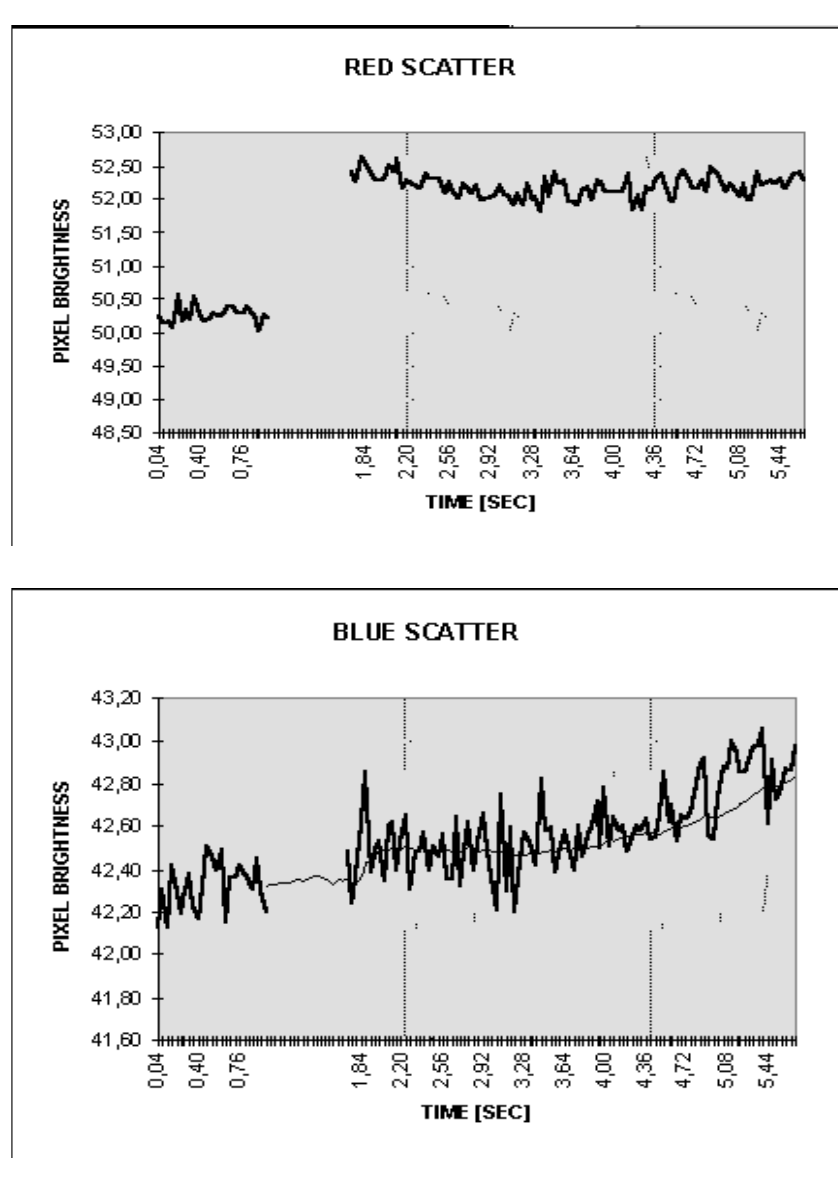
Figs. 2A and B – Mean brightness of a 750 µm 2 area centered at the pixel with the stimulating needle tip and calculated in a 125 frames sequence (25Hz video acquisition frequency). The sequence begins one second (25 frames) before stimulation. The interval corresponds to the first 600 ms after the stimulus in which there was artifact from the touching and withdrawing needle. After this interval, the mean brightness was calculated in the next 4 seconds terminating just at the transition to propagating wave. In A the mean brightness of the red (625nm) scatter is shown. Note the discontinuous, bi-stable behavior. In B the mean brightness of the stimulated area is shown for the blue (475nm) scatter. A slow ramp behavior is apparent and it is accentuated by a smoothing procedure of the data (moving average using 25 sequential points in each average) shown in the black